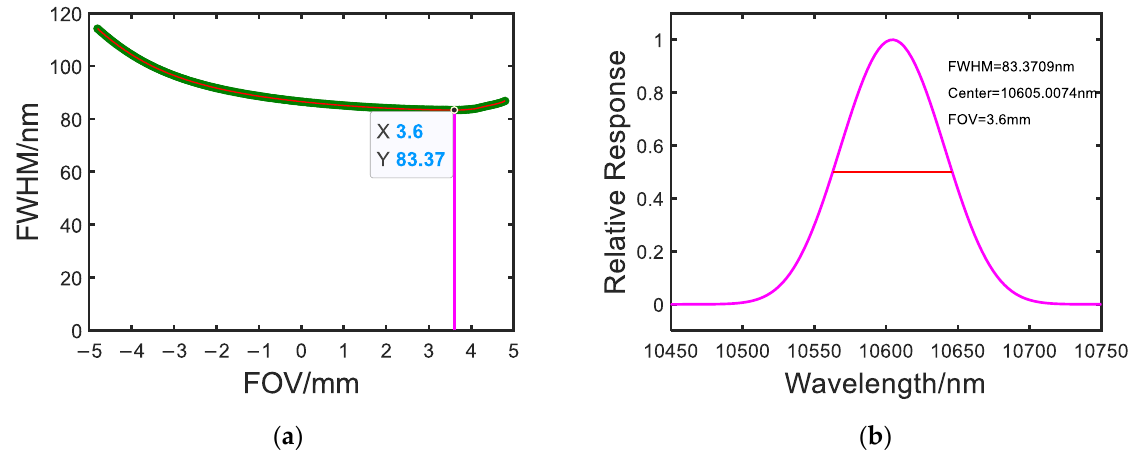
Figure 11. Simulation of the inclined slit image at 293 K. ( a ) the FWHM of the slit image; ( b ) the discrete sampling curve of the slit image.